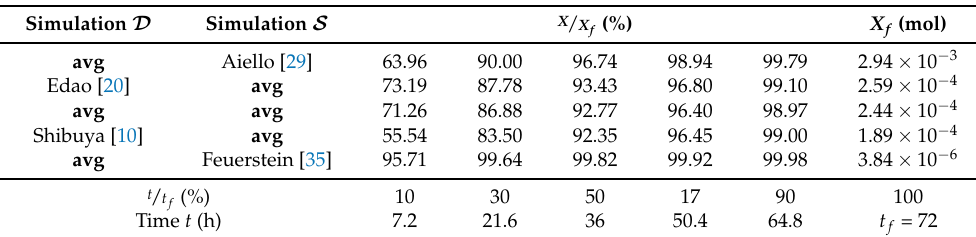
Table 4. Evolution of gas amount dissolved in Pb-Li ( X ) at given simulation times ( t ), for simulations using same parameter combinations as shown in Figure 14. Dissolved gas amounts in middle columns are given in percentages, calculated in relation to gas amounts at final simulation time step ( X f ), for simulations up to t f =